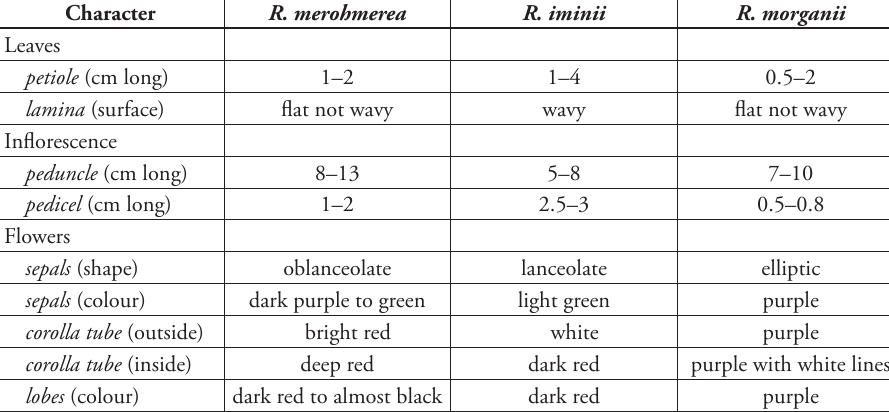
Table 1. Main morphological differences among the similar species of